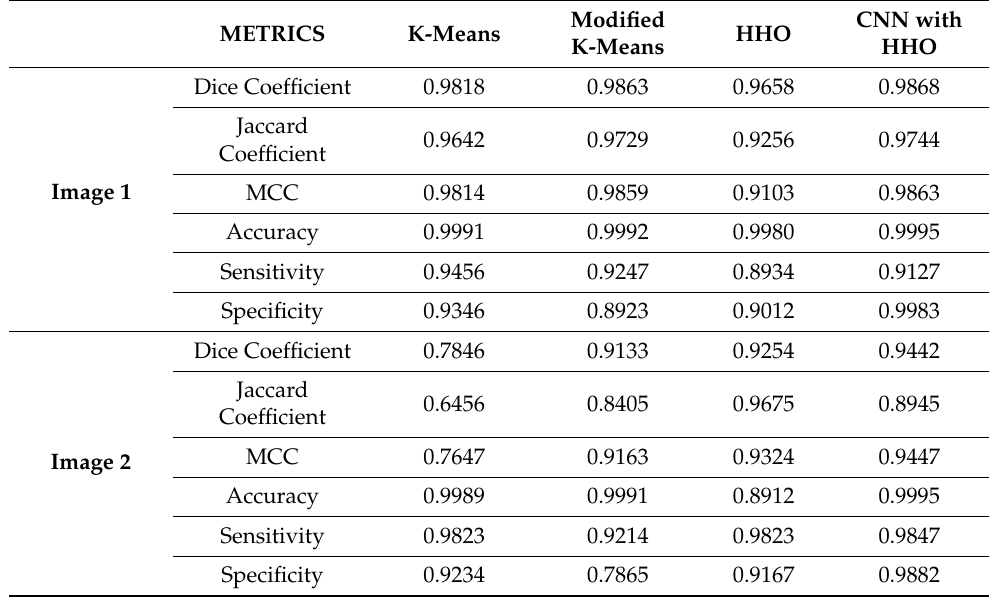
Table 12. Performance evaluation of proposed segmentation